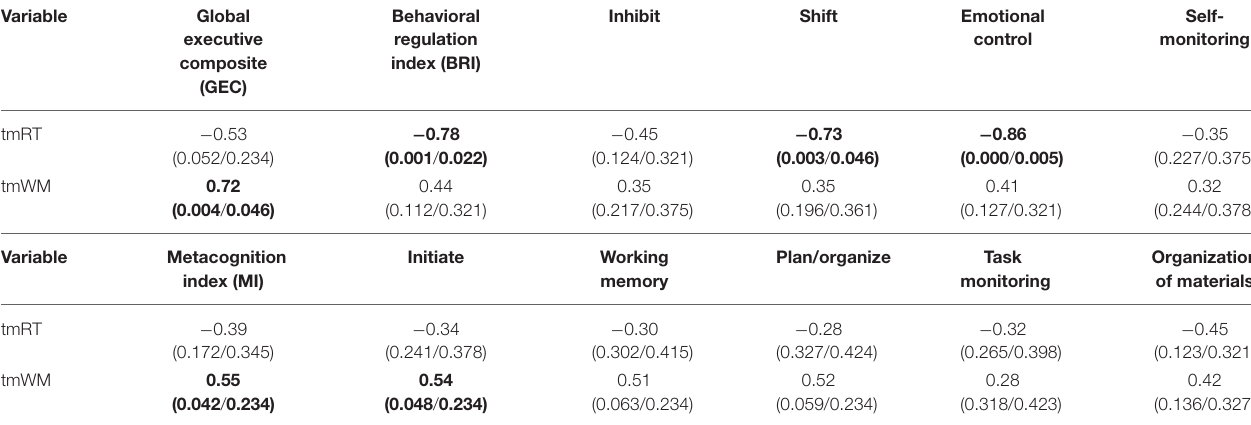
TABLE 3B | Significant correlations between threat modulation indices and BRIEF-A questionnaire post-ECT.